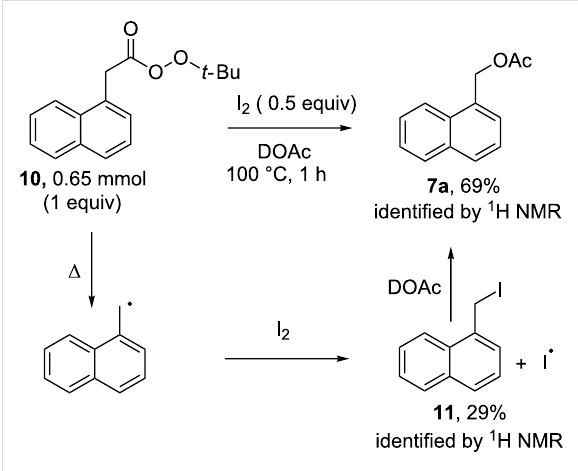
Figure 6: Pyrolysis of an acyl perester in the presence of molecular